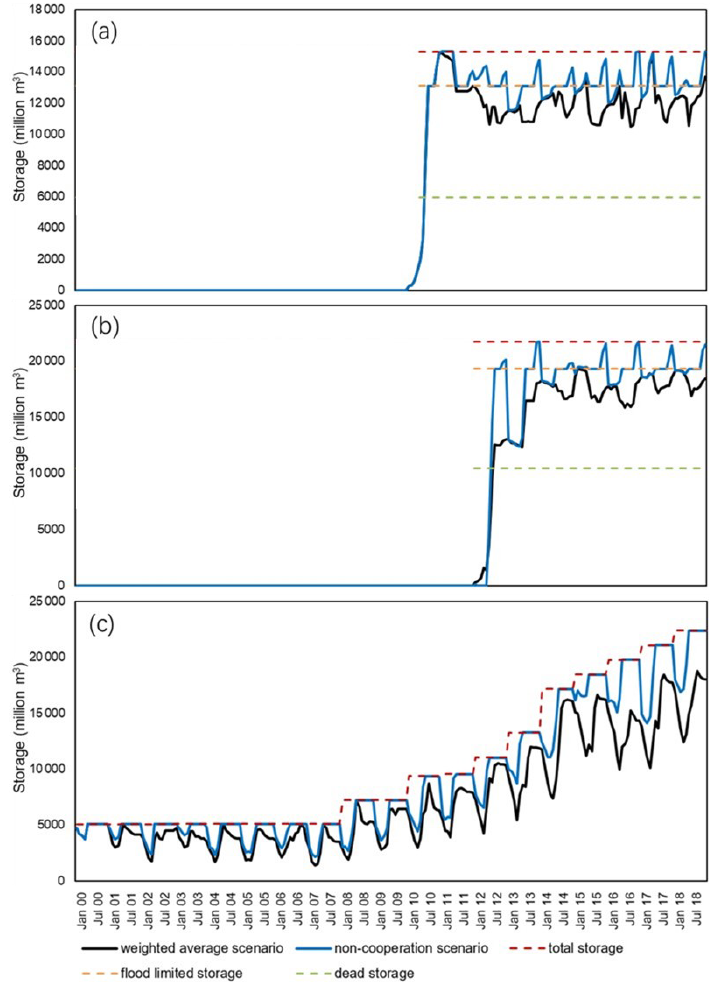
Figure 8. Simulated storage dynamics of Xiaowan (a) , Nuozhadu (b) and virtual Laos reservoir (c) . Total storage in panel (c) indicates total active storage of the virtual Laos